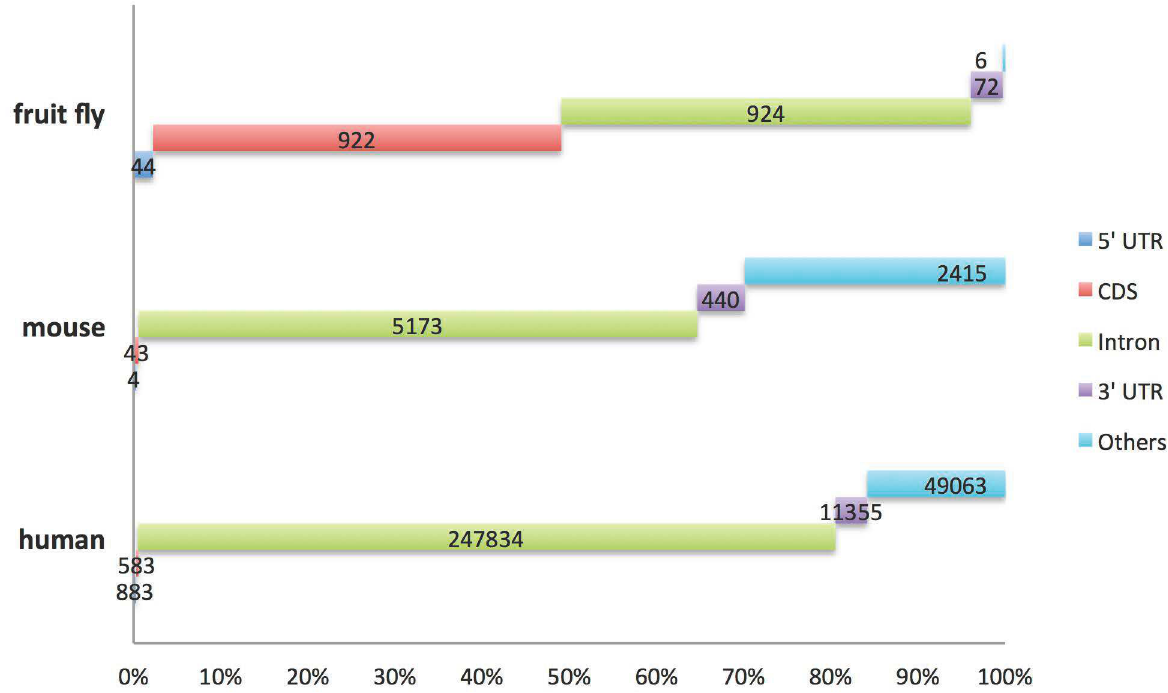
Fig 2. The genomic distribution of A-to-I RNA editing events. Gene annotationhere was derivedfrom the DARNED (http://darned. ucc.ie/help/). 5’ UTR: 5’ untranslated regions. 3’ UTR: 3’ untranslated regions. CDS: coding region of a gene. An "other" region refers to an RNA editing coordinate not part of an intron or